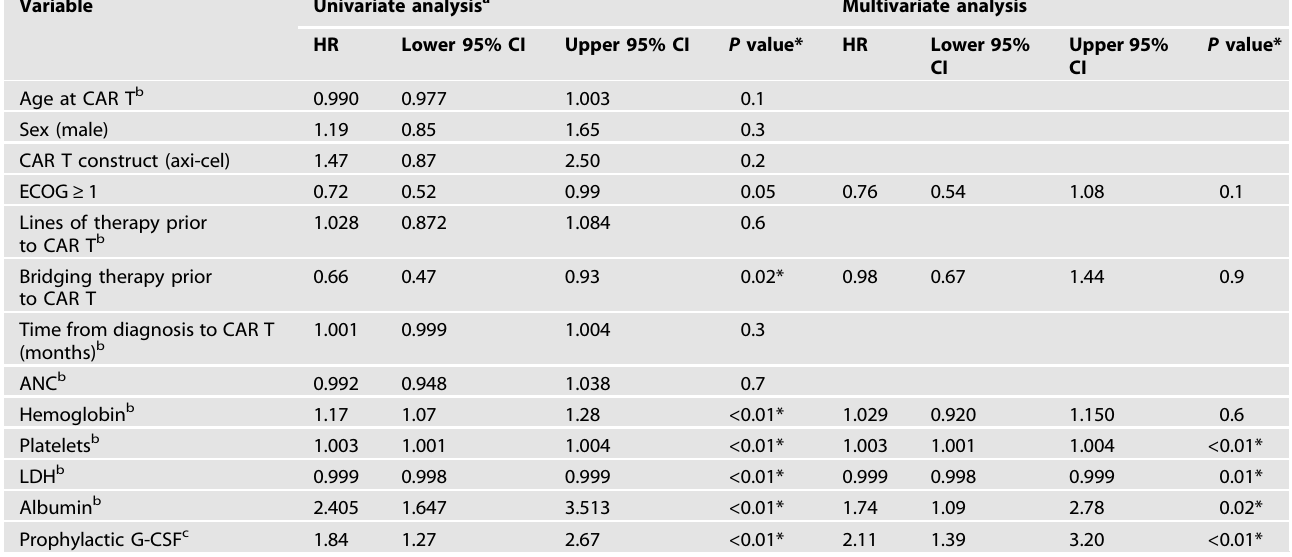
Table 2. Cox proportional hazards model for time to neutrophil recovery in lymphoma cohort.